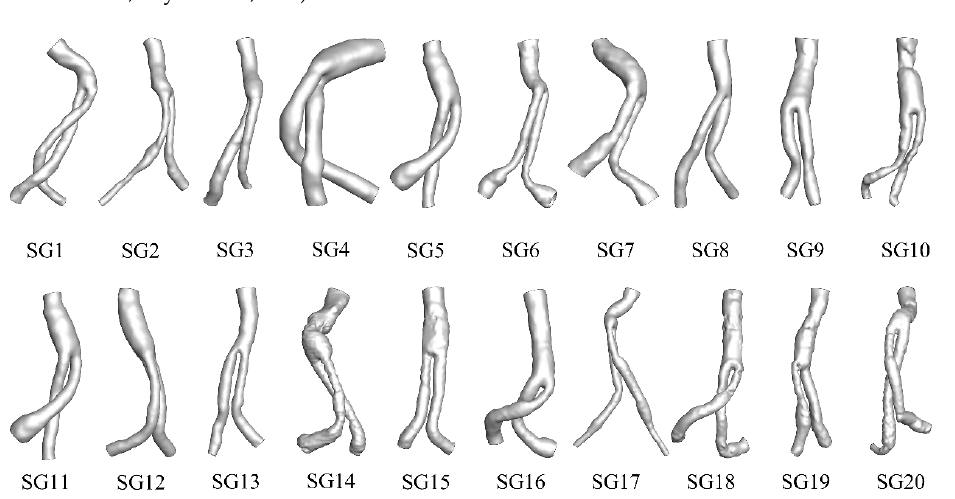
Figure 1. Schematic diagram of the patient-specific models.